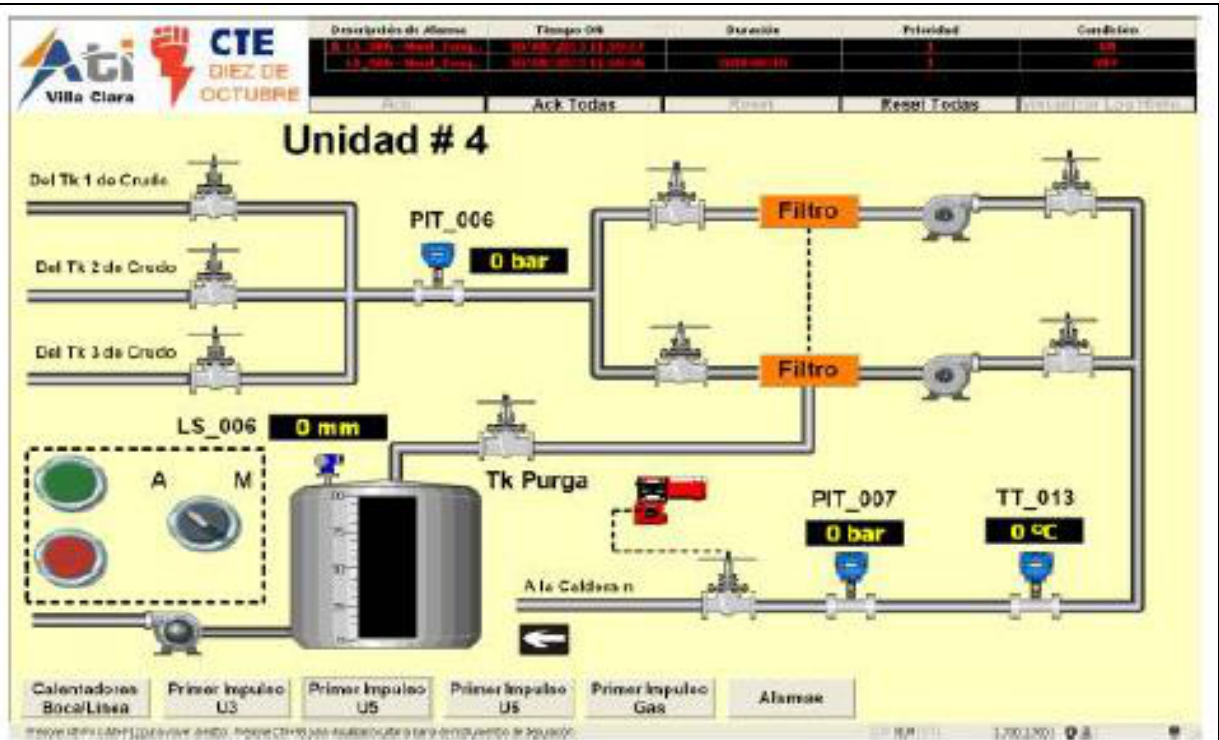
Figura 14: Una de las pantallas de la aplicación SCADA, usando Movicon, desarrollada para el sistema de trasiego de combustible. Fuente: Los Autores,